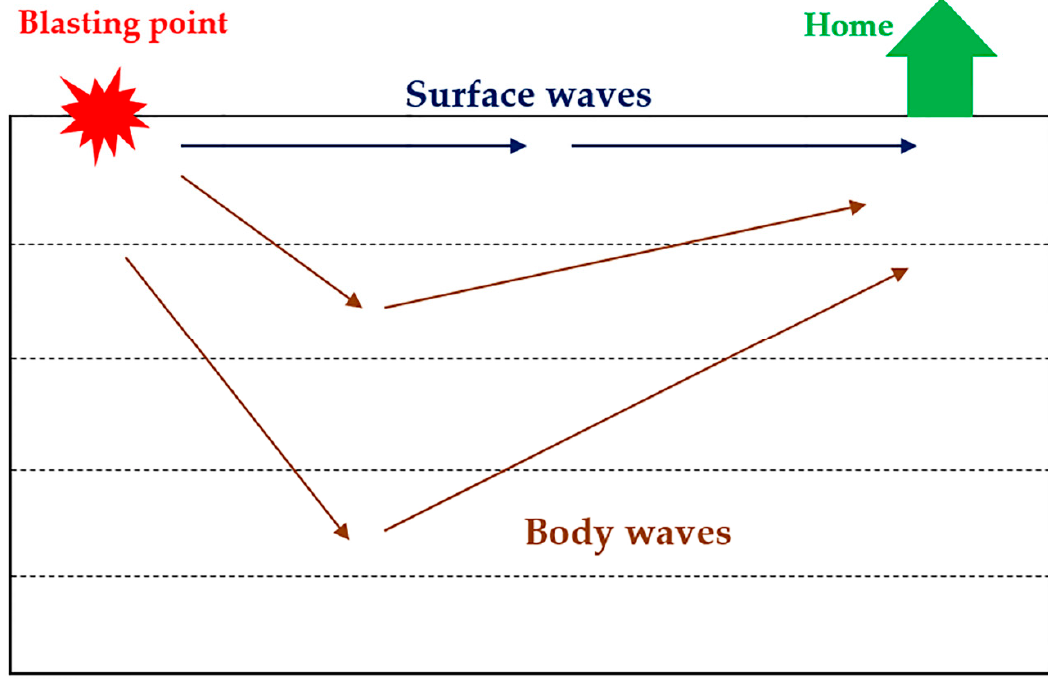
Figure 1. Waves generated by blasting.